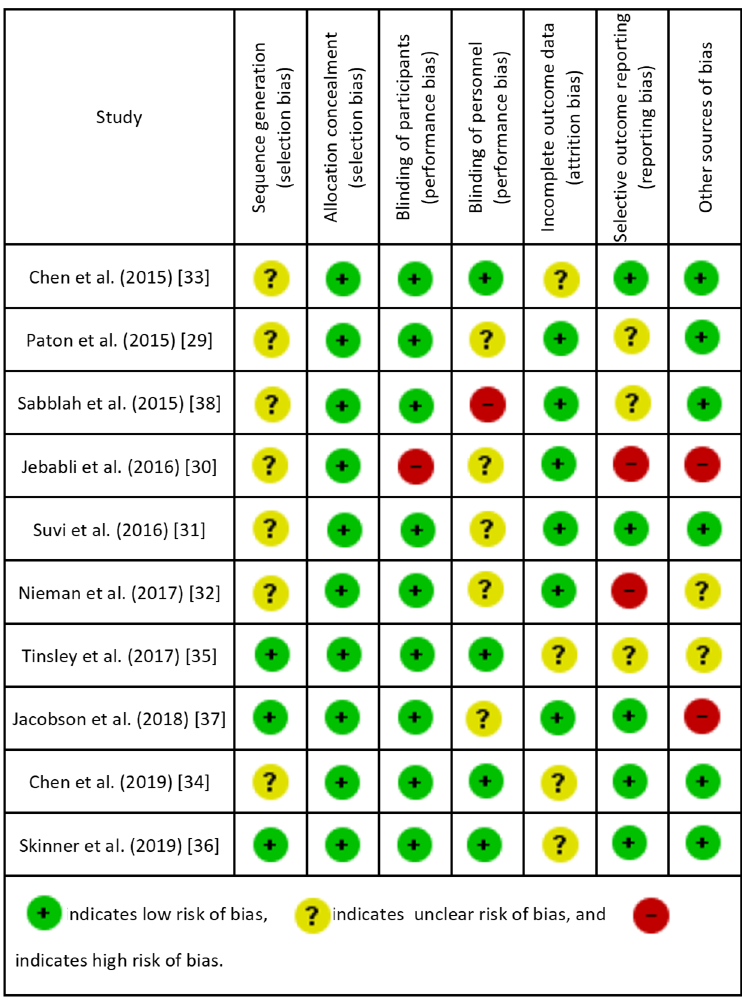
Figure 2. Risk of bias summary: review of authors´ judgements about each risk of bias item presented as percentages across all included studies. Nutrients 2019 , 9 , x FOR PEER REVIEW